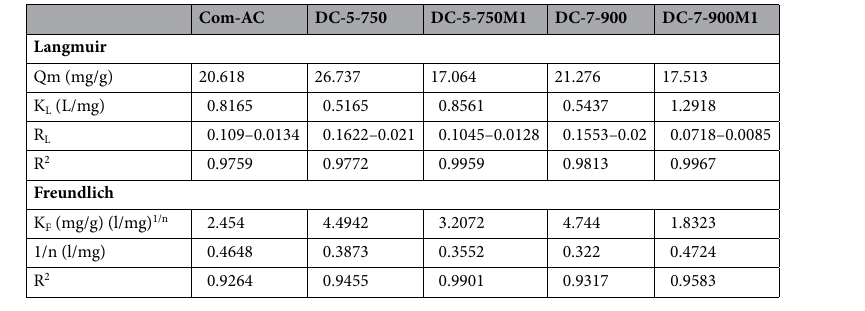
Table 11. Value of isotherms parameters of nitrate